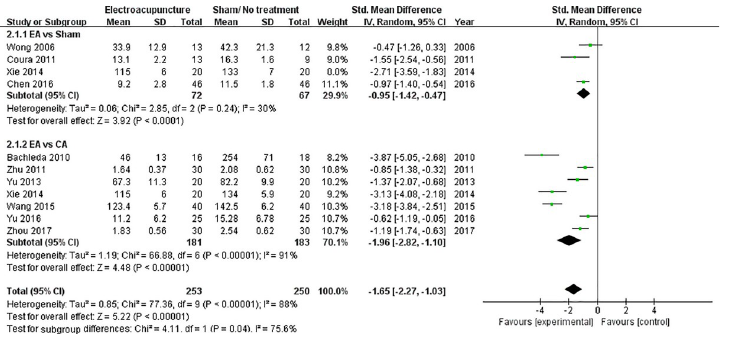
Fig 6. Final forest plot of total dose of opioid analgesics after sensitivity